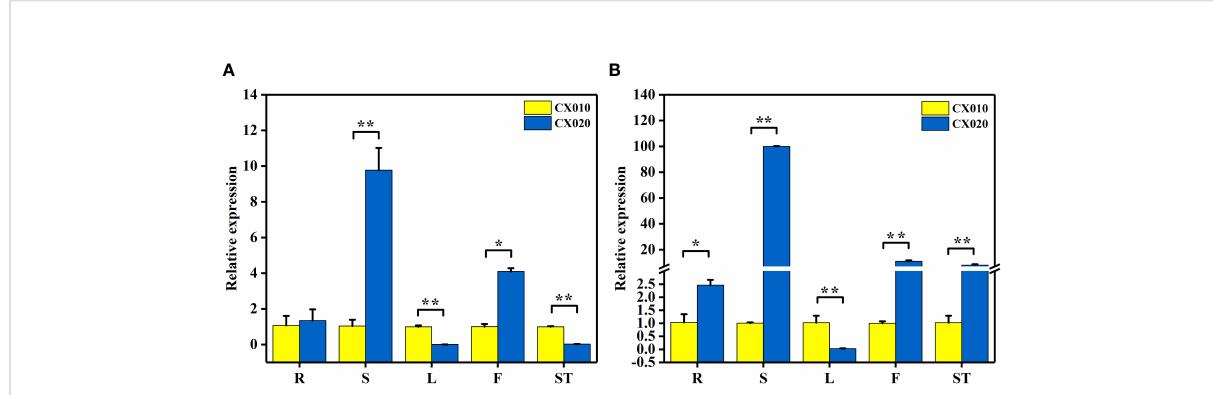
FIGURE 4 Expression levels of BraA07g041560.3C and BraA07g041570.3C in different tissues of CX010 and CX020 plants based on qRT-PCR. (A) The expression level of BraA07g041560.3C. (B) The expression level of BraA07g041570.3C. R, whole roots; S, rosette stems; L, tender cauline leaves; F, fl owers of top in fl orescences; ST, shoot tips. The data shown are the means of three replicates (± SD). * and ** indicate signi fi cant differences in expression levels at P < 0.05 and P < 0.01, respectively (Student ’ s t